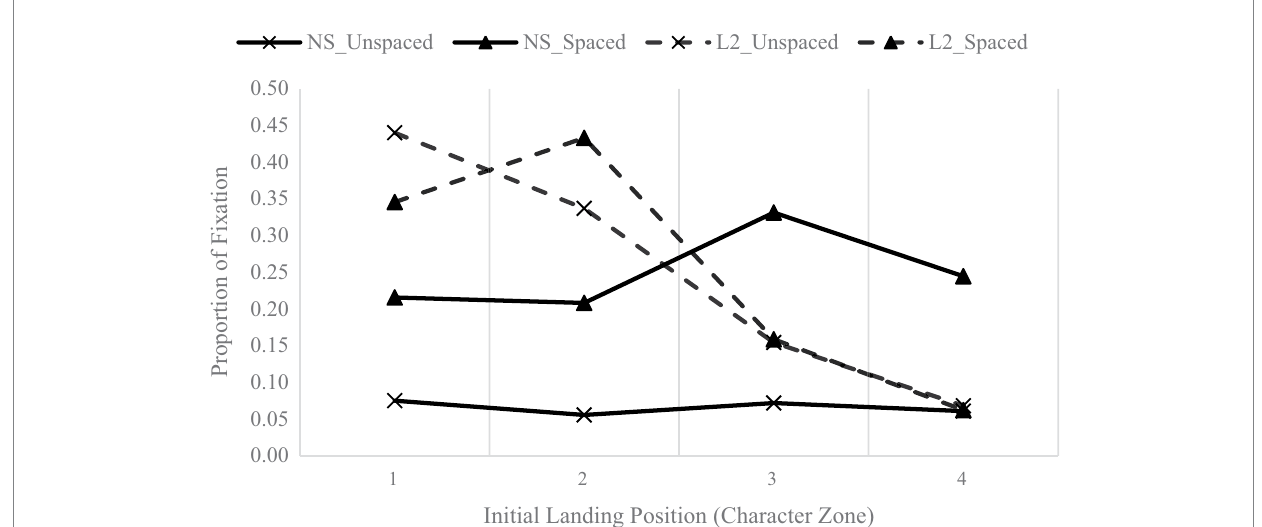
FIGURE 4 The distribution of landing positions in multiple fixation